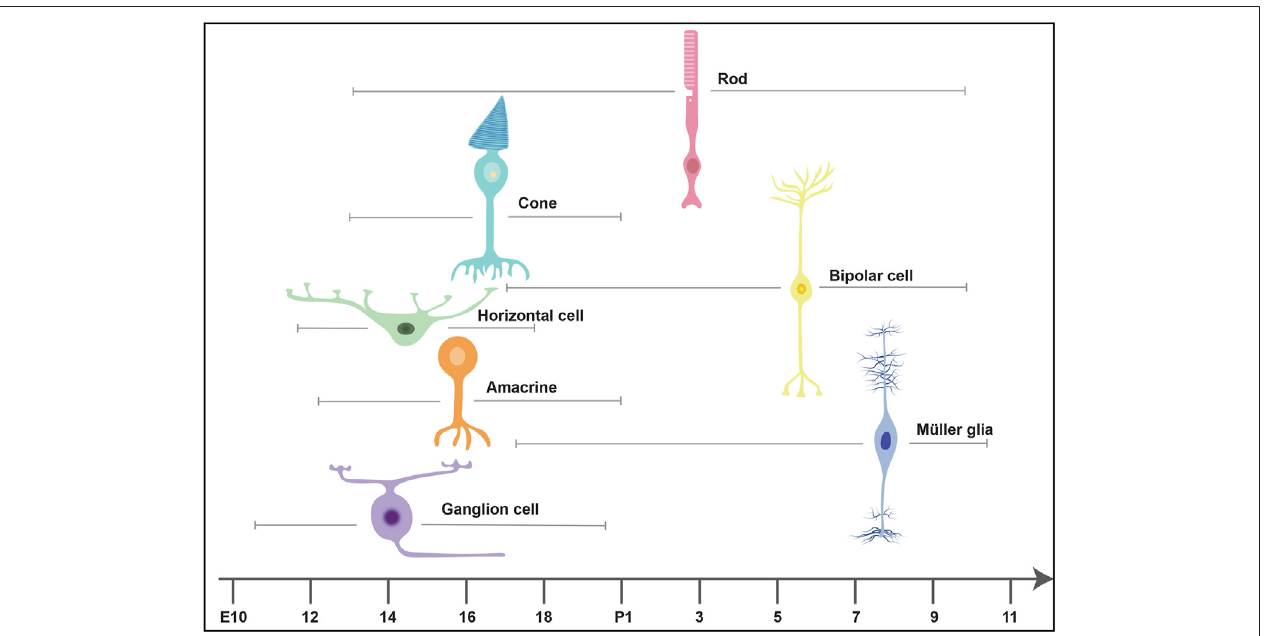
FIGURE 8 | Timing of retinal cell differentiation in the murine retina. The seven retinal cell types are generated in overlapping waves. The embryonic wave involves the sequential but overlapping differentiation or ganglion cells, amacrine cells, horizontal cells and cones, which are born between embryonic day (E) 10 and postnatal day (P) 2. The postnatal wave includes the differentiation of rods, bipolar cells and Müller glia.